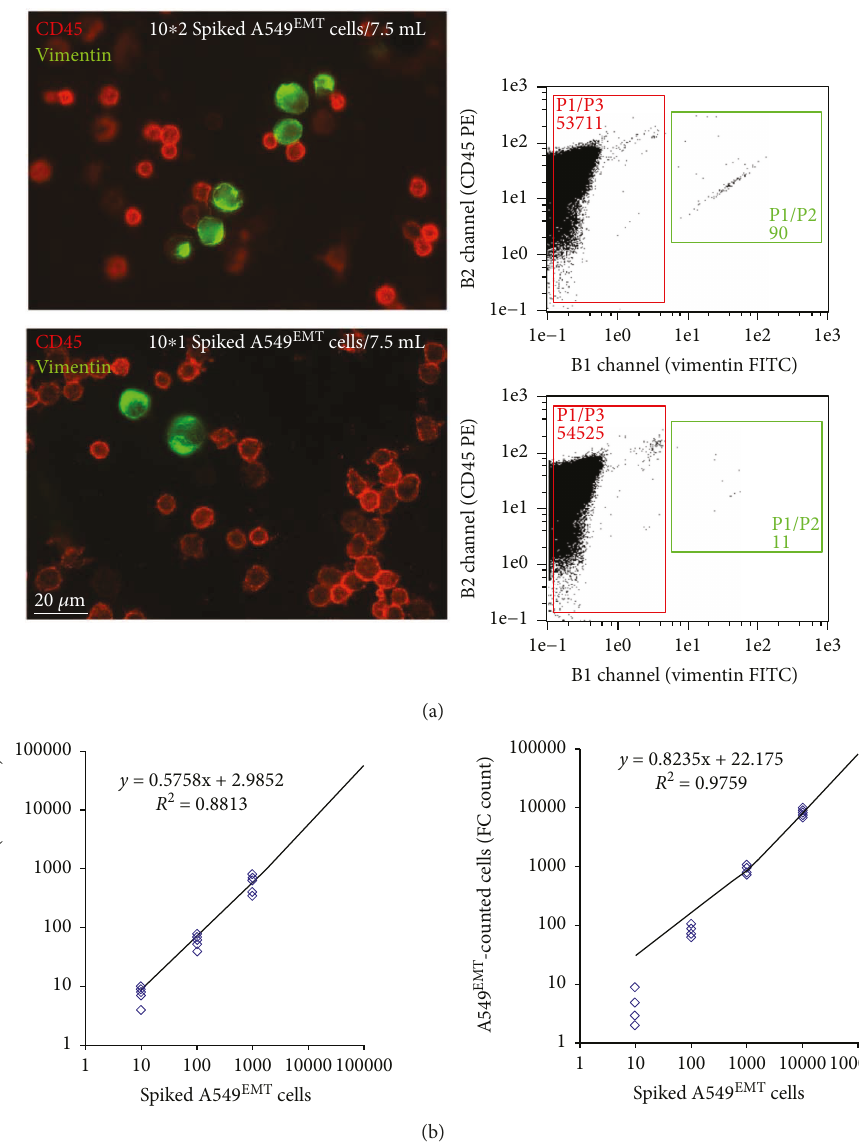
Figure 3: Recovery experiments of spiked A549 EMT cells and linearity assessment of control methods for cell count. (a) qIF and CF cell counts of spiked A549 EMT cells. All dilutions were analyzed in parallel; the mean recovery rates at lower dilutions (10 1 and 10 2 ) were of 61 ± 14% and 80 ± 17% for qIF and 84 ± 16% and 56 ± 32% for CF. (b) Evaluation of the linearity of qIF and CF cell counts. The linearity of both methods was veri fi ed by linear analysis of regression curve ( r 2 : 0.88 and 0.97 for qIF and CF assays,